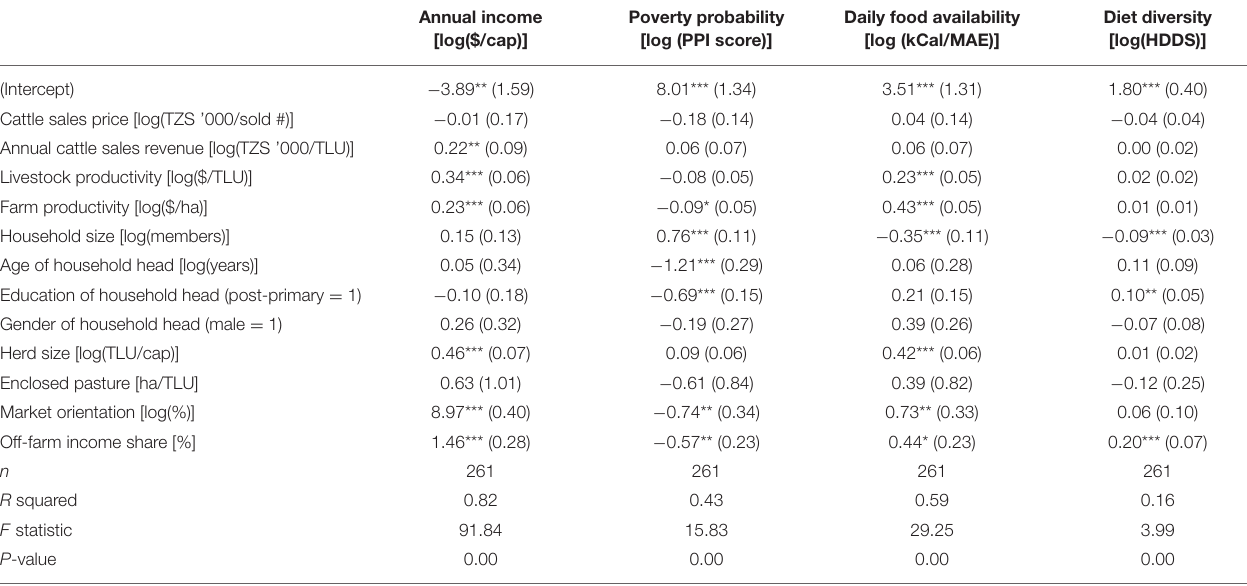
TABLE 10 | Association of farm success with household livelihood